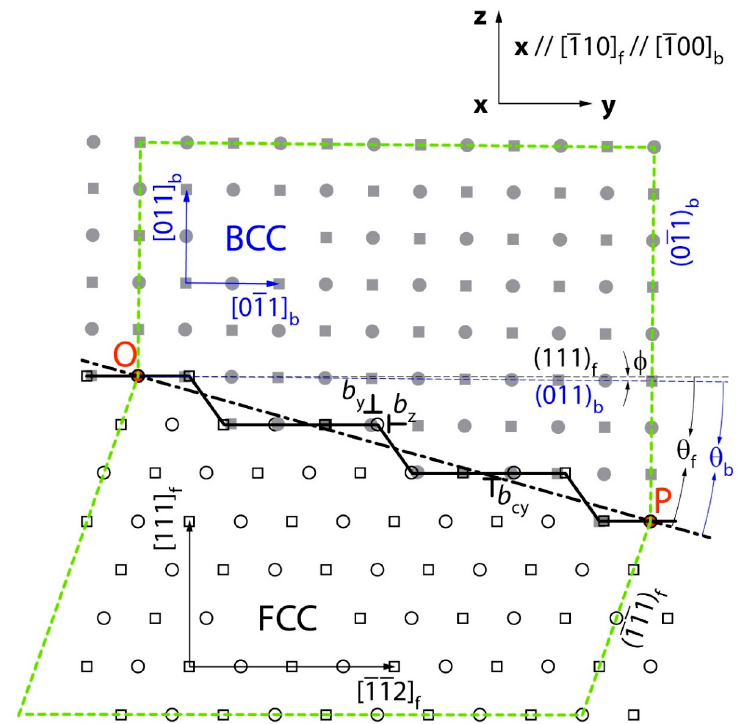
Figure 3. The topological version of the long-range strain-free interface containing a series of disconnections between FCC Cu and BCC Cr. The dashed-dotted line refers to the average orientation of the interface while the bold solid line outlines the actual interface consisting of terrace and steps. The green dashed lines indicate the Burgers circuit between perfectly matched lattice points O and P, located at terrace centres from different layers. The circle and square patterns have the same meaning as those in Figure 1.